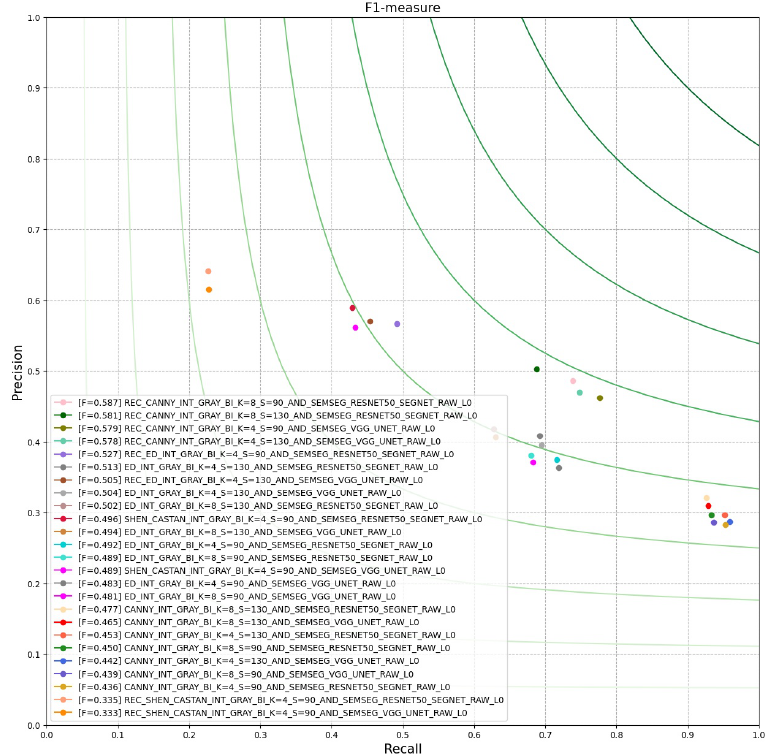
Figure 23. ROC plot of best 25 best PCM results.